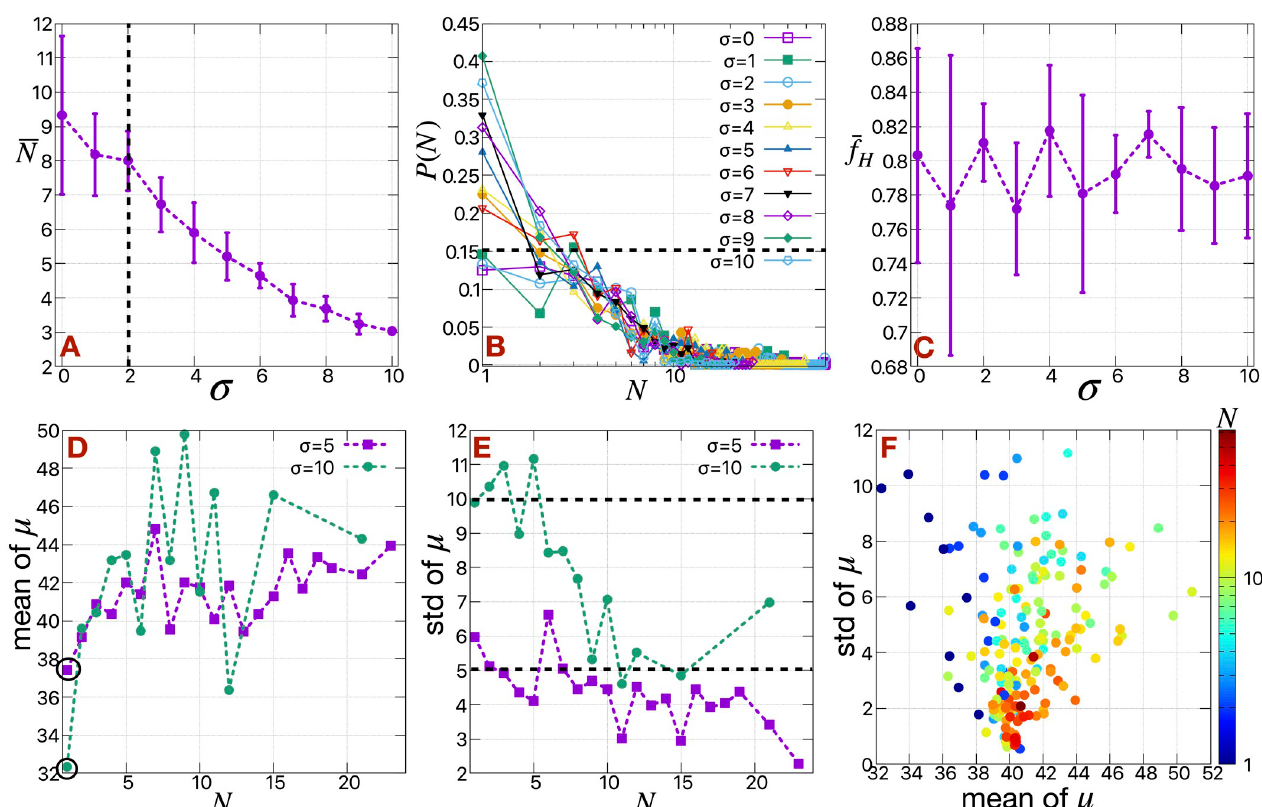
Fig 7. Details of the clusters composed of a spectrum of EMT states. (A) The mean cluster size ( N ) of H cells as a function of σ , when motile forces of all the H cells are drawn from a normal distribution of mean 40 and standard deviation σ at Γ = 3. (B) The corresponding cluster size distributions for different values of σ . The distributions are normalized such that ∑ P ( N ) = 1. The N axis is in log scale. (C) The fraction of H cells ( f We use standard deviations of the data as error bars. The (D) mean and (E) standard deviation (std) of μ for each cluster size N in case of σ = 5 and 10. (B) The heat map of cluster sizes ( N ) as function of mean and standard deviation (std) of motile forces ( μ ). The N is in log scale.